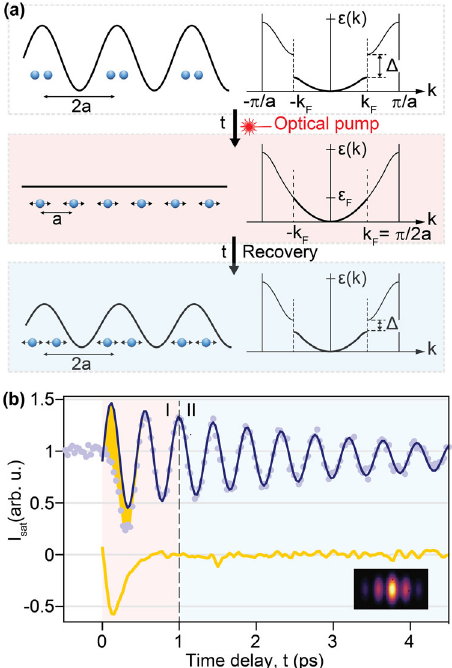
Fig. 1 Time-resolved measurement of the electronic order formation in presence of acoustic phonons. a The laser pulse quenches the spin density wave (SDW), which is coupled to the periodic lattice distortion (PLD) (solid line on the left), and launches a pair of longitudinal acoustic phonons (atomic positions (blue spheres) and their wavevector (black arrows)). Subsequently, the SDW bandgap (schematic energy diagram on the right) reopens and the coupled SDW-PLD state reforms in presence of the phonons. b Typical time-resolved X-ray diffraction data of the coherent satellite-peak (purple dots) for an incident pump fl uence of 2 mJ/cm 2 . The data is fi tted (purple solid line) with a damped harmonic oscillator in region II (blue shaded area), the fi t is extrapolated to region I (red shaded area), and the extrapolated fi t is subtracted from X-ray diffraction data. The residual is shown in orange and is proportional to the transient PLD amplitude coupled to the SDW through spin – lattice interaction. The inset shows typical diffraction data as measured on the two-dimensional detector for a single time delay. The coherent satellite-peak is in the center at Q 002 – Q L = 4.17 Å − 1 , the image spans 0.14 Å − 1 horizontally, and the intensity drop towards the sides of the detector is due to the Ewald sphere intersecting the Bragg rod under an angle of 30